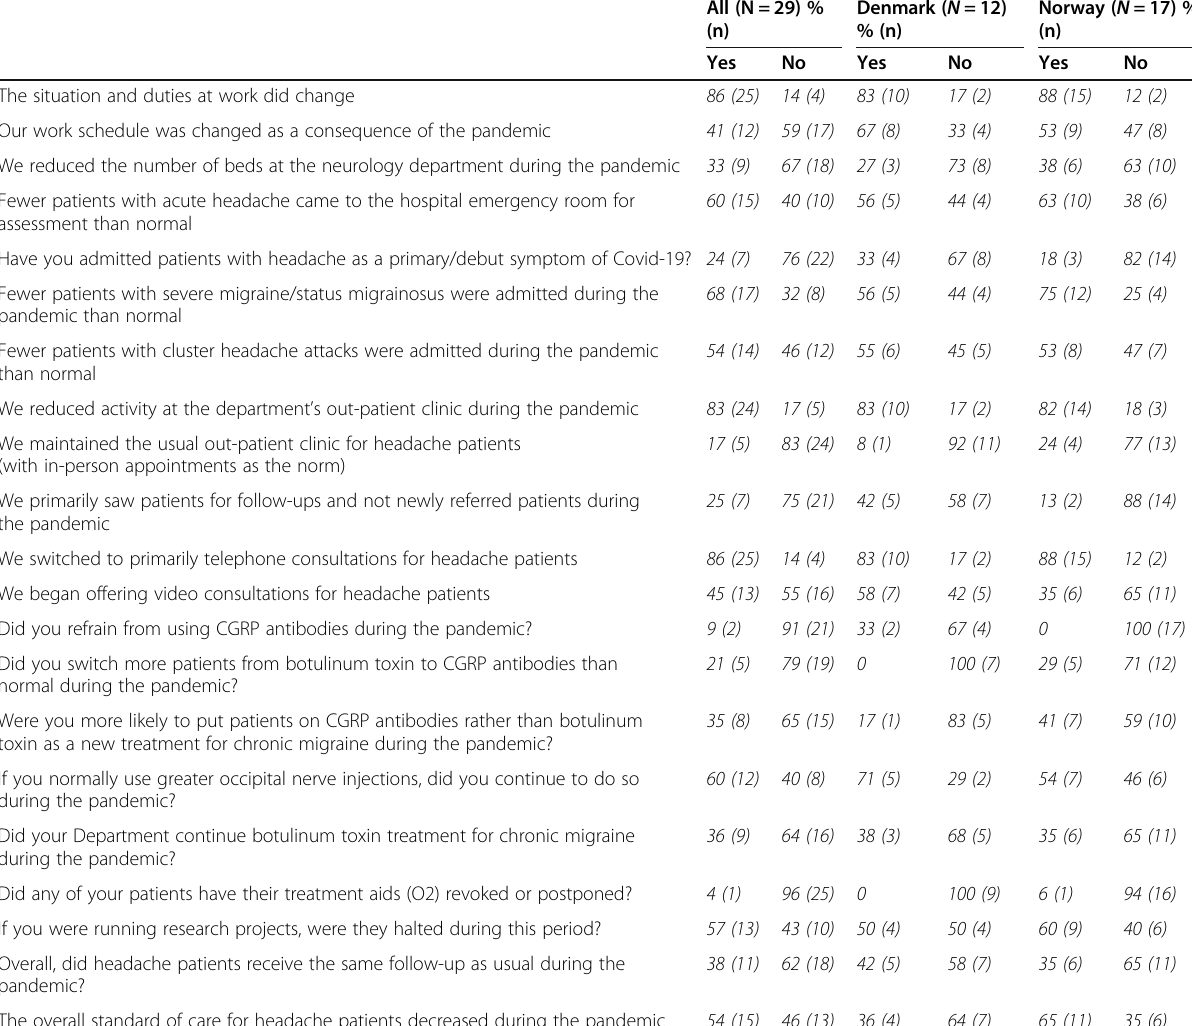
Table 1 Data on hospital-based headache care during the Covid-19 pandemic in Denmark and Norway ( N = 29)